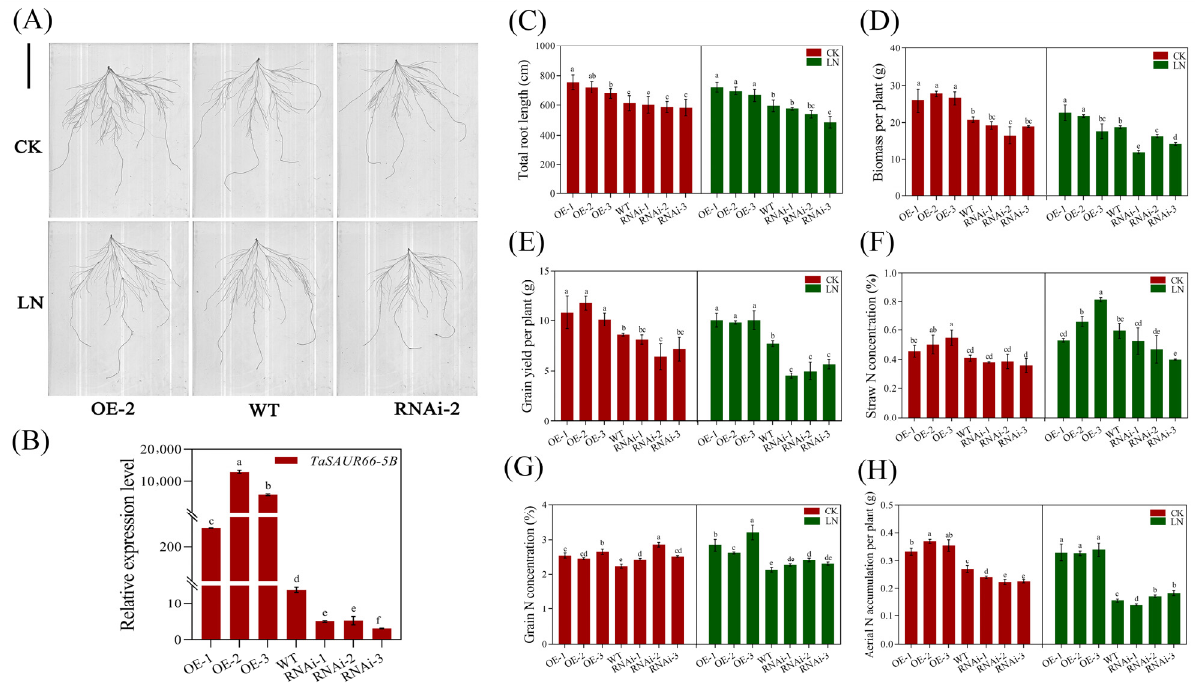
Figure 6. Overexpression of TaSAUR66-5B in wheat promotes root growth and improves nitrogen use efficiency (NUE). ( A ) The root morphology of representative plants of WT and transgenic line under normal nitrogen (CK) and low nitrogen (LN) conditions. Bar = 10 cm. ( B ) Relative expression levels of TaSAUR66-5B gene in different wheat transgenic lines. The relative expression level of TaSAUR66-5B was normalized to the expression of β -TaTubulin , 2 − △ Ct . ( C ) The total root length of each wheat transgenic line under CK and LN conditions. ( D ) The biomass per plant, ( E ) grain yield per plant, ( F ) straw nitrogen concentration, ( G ) grain nitrogen concentration, and ( H ) aerial nitrogen accumulation of transgenic lines and WT under CK and LN conditions, respectively. The data are expressed as the mean ± SD of three biological replicates. Different lower case letters above columns indicate statistical differences at p < 0.05 level.